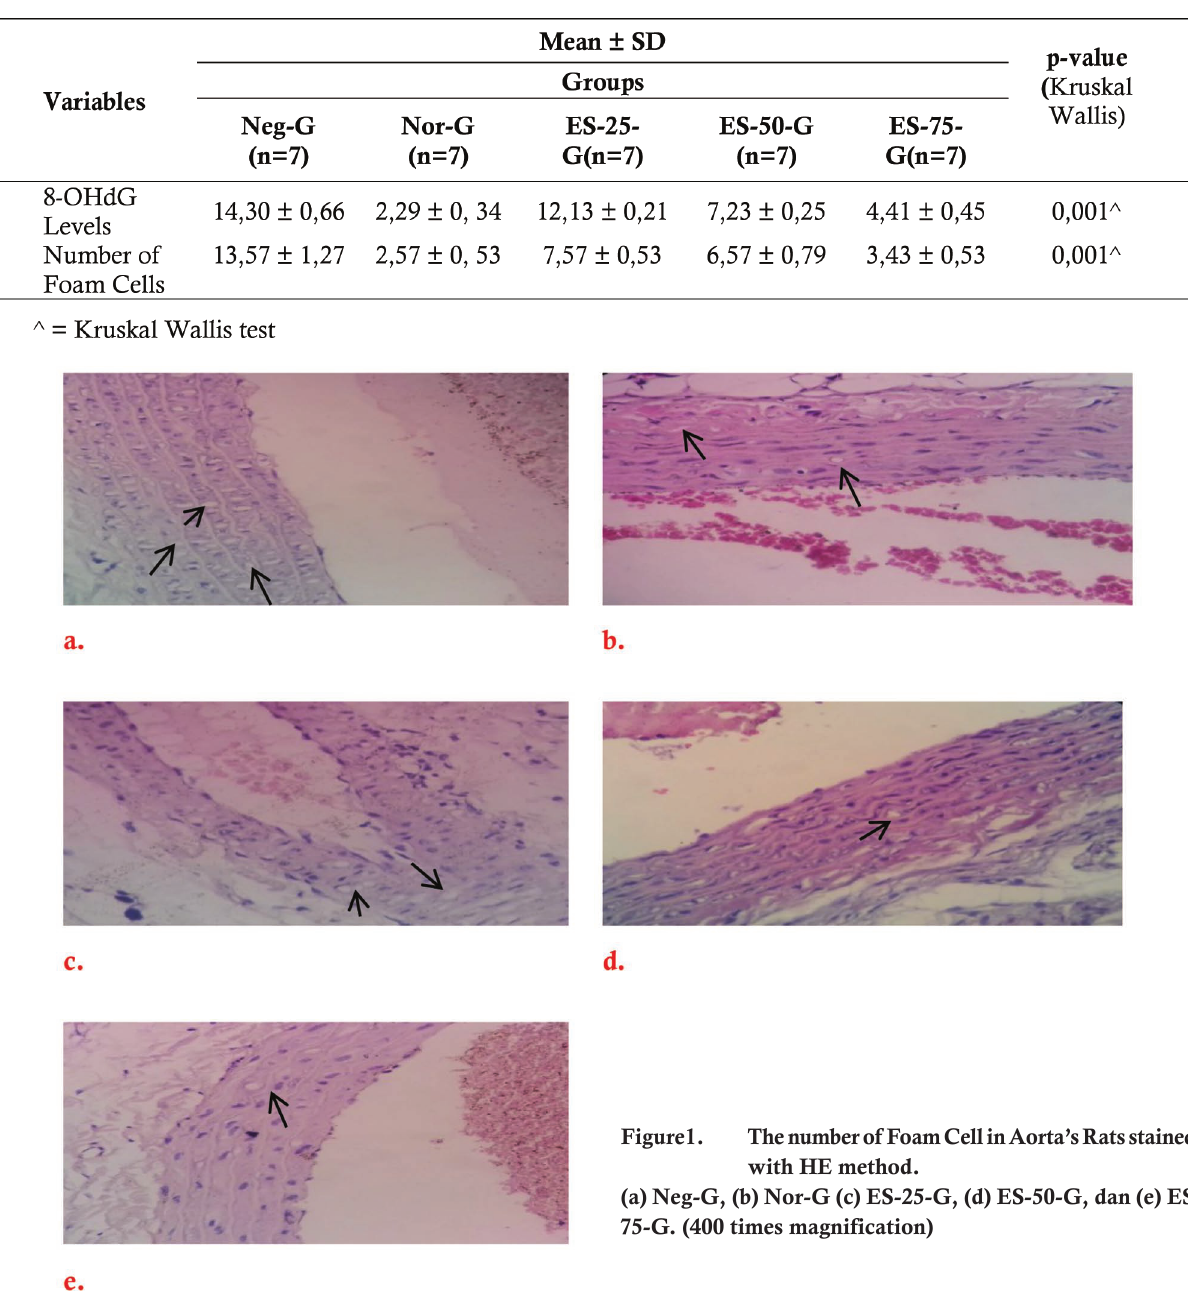
Figure1. The number of Foam Cell in Aorta’s Rats stained with HE